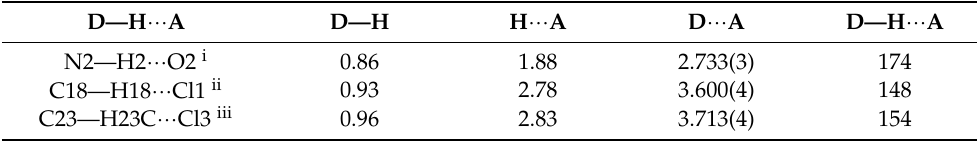
Table 3. Hydrogen-bond geometry (Å, ◦ ) existing in